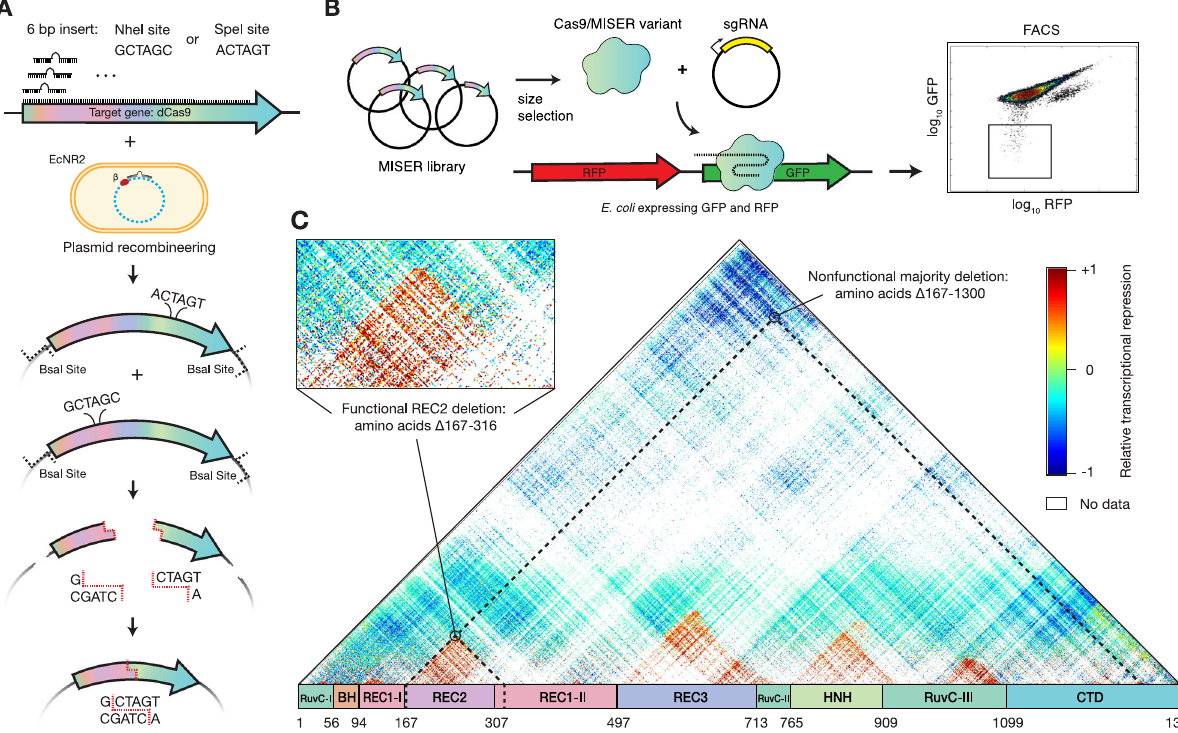
Fig. 1 Minimization by iterative size exclusion and recombination (MISER). A MISER library construction. A 6-bp Spe I or Nhe I recognition site is inserted separately into a dCas9-encoding plasmid fl anked by Bsa I sites using plasmid recombineering. The resultant libraries are digested with Bsa I and either Spe I or Nhe I, and the two fragment pools are combined and ligated together to generate a library of dCas9 ORFs possessing all possible deletions. B The MISER library is cloned into a vector and co-transformed in E. coli expressing RFP and GFP with a sgRNA targeting GFP. The library products are expressed, functional variants bind to the target, and repress the fl uorophore. Repression activity in vivo is measured by fl ow cytometry. C Enrichment map of the MISER deletion landscape of S. pyogenes dCas9. A single pixel within the map represents an individual variant that contains a deletion beginning where it intersects with the horizontal axis moving to the left (N) and ends where it intersects with the axis moving to the right (C). Larger deletions are at the top, with some deletions almost spanning the whole protein. The heatmap shows relative repression activity of variants from two FACS sorts of a single replicate. The map is a composite of Slice 4 and Slice 5 in Supplementary Fig. 3A, B, which present variant ratios post- versus pre-FACS